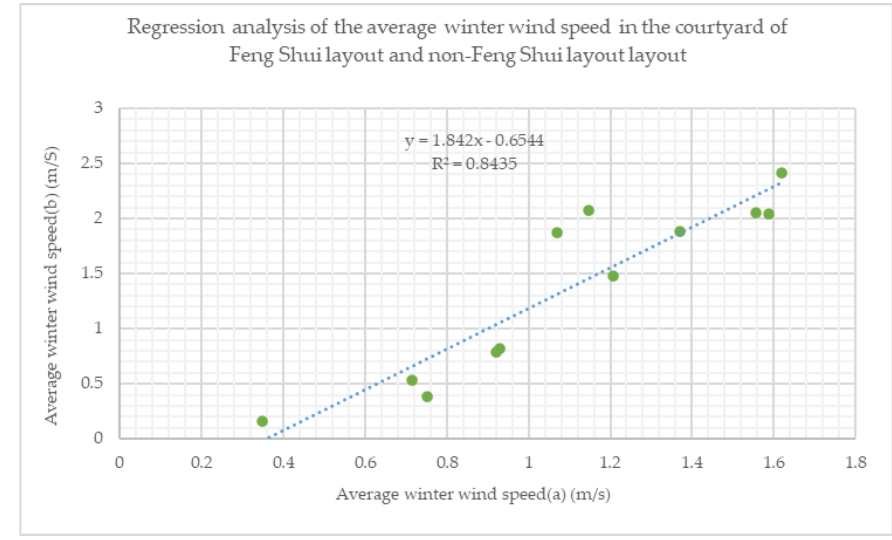
Figure 16. Linear regression graph of the average wind speed data for courtyards under Feng Shui and non-Feng Shui layouts. The data for the graph were obtained through CFD simulations.